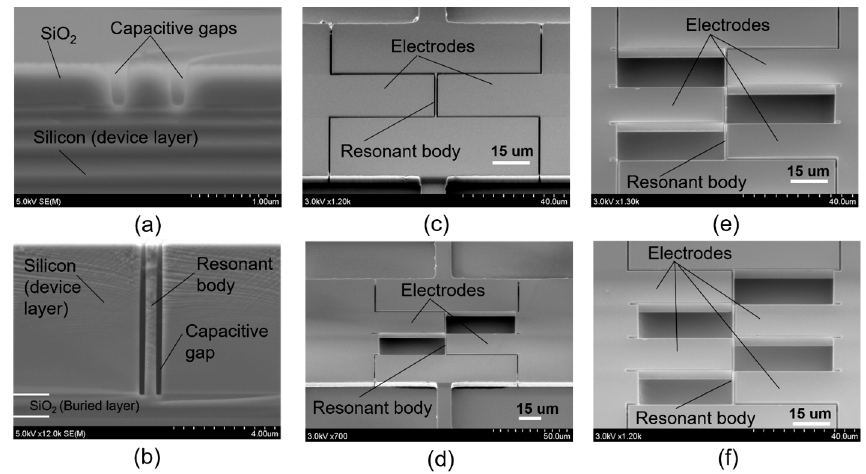
Figure 4. Fabricated results. ( a ) SiO 2 patterning with EB resist and using the RIE technique; ( b ) resonant body and narrow trenches formed by deep RIE; ( c ) first mode vibration structure; ( d ) second mode vibration structure; ( e ) third mode vibration structure; ( f ) fourth mode vibration structure.